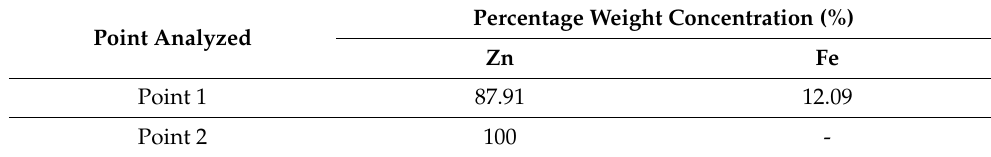
Table 4. Chemical composition (at%) of the EDS